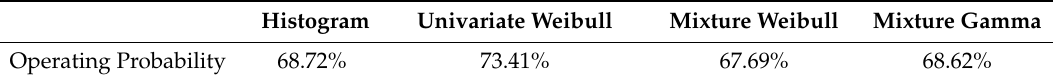
Table 5. Operating probability for